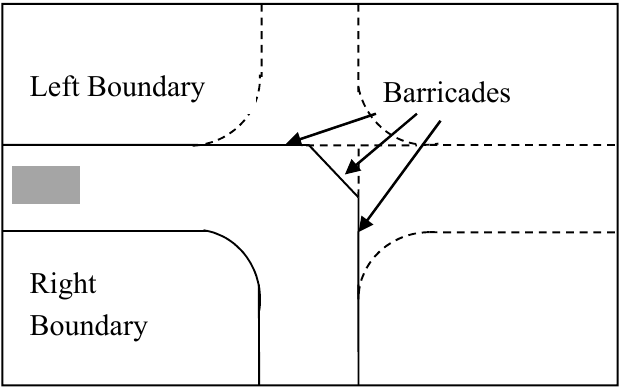
Figure 8. Use of virtual barricades for crossing